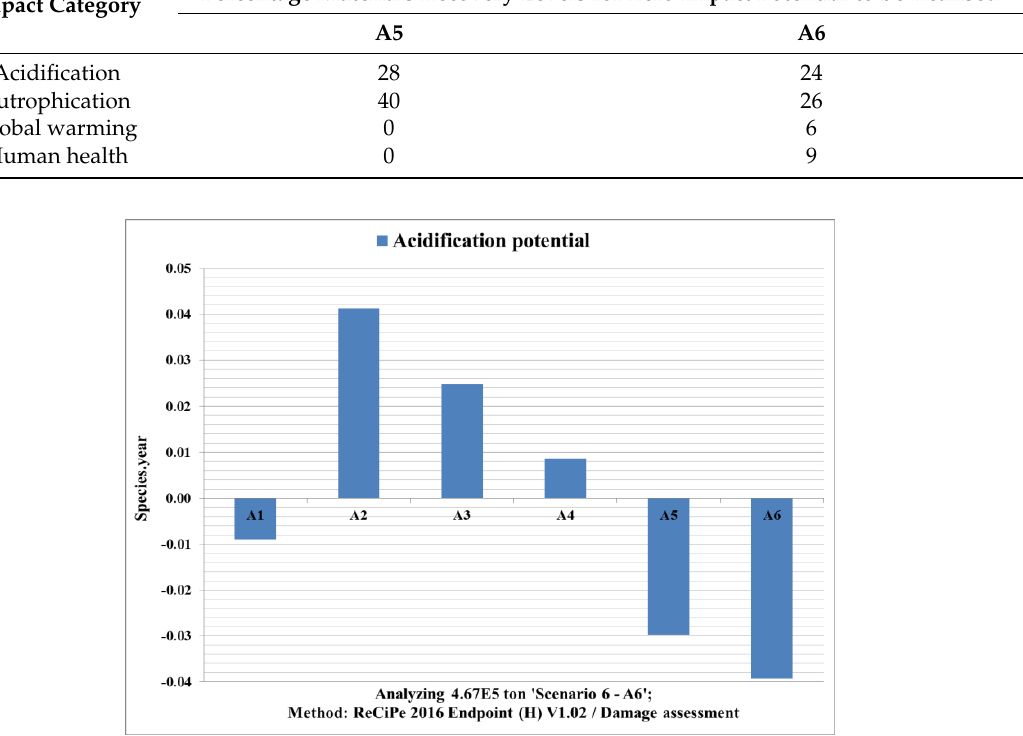
Figure 4. Acidification impact potentials.